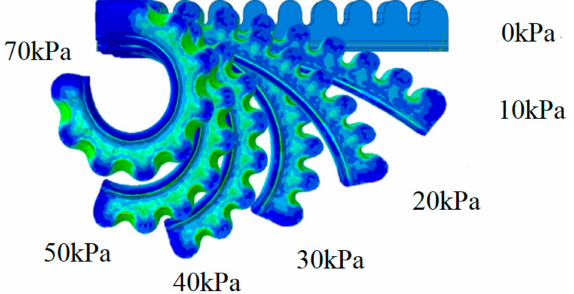
Figure 5. Soft bending actuator trajectory for bending angle from 0 kPa to 70 kPa.